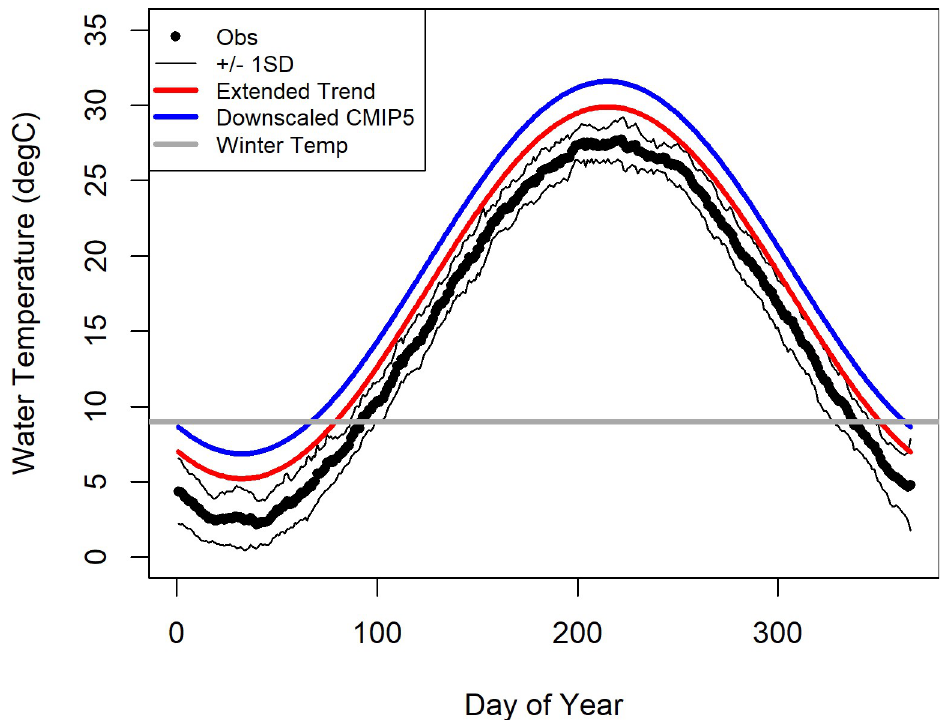
Fig 2. Climatology of observed historical water temperature (Obs) in the reference period (1961–1990) and the projected future water temperature (red and blue lines) in the prediction period (2070–2099). The grey line is at 9˚C and represents the temperature at which crabs will commence overwintering. Both the conservative estimate of the increase in water temperature (Extended Trend, red line) and the projected water temperature from the multi-model enseble of downscaled GCM models (Downscaled GCM, blue line) predict the average year in the prediction period will be warmer than the average year in the reference